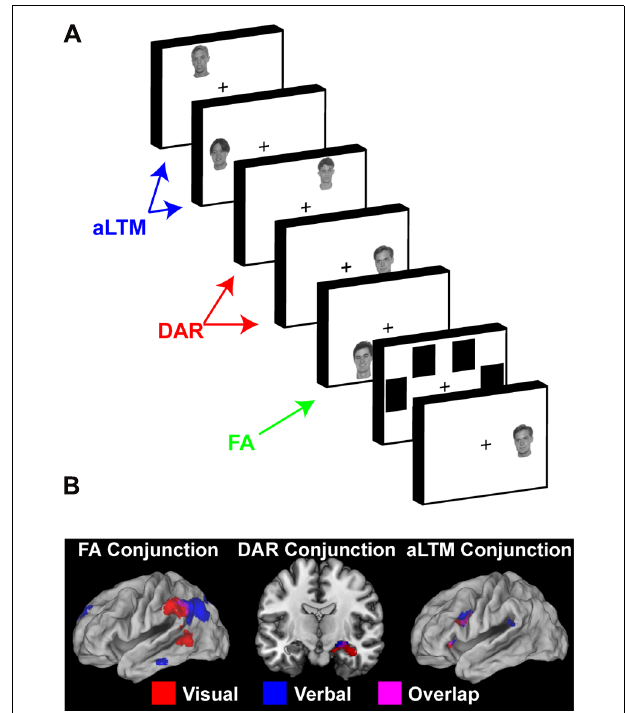
FIGURE 3 | Neural evidence for a three-state model of memory. (A) The task used by Nee and Jonides (2013) to examine neural correlates of the focus of attention (FA), direct-access region (DAR), and aLTM in visual STM. The task involved sequential presentation of five faces followed by a mask and a recognition probe. In this task, the number of presented items exceeded the capacity of the direct-access region. So, it was assumed that the least recent items (i.e., first presented items) would no longer be contextually bound and be represented in aLTM rather than the direct-access region. Reprinted from Nee and Jonides (2013) with permission from Elsevier. (B) Conjunction of results across a six-word version of the paradigm depicted in Figure 2 (Nee and Jonides, 2011) and the five-face paradigm depicted in (A) (Nee and Jonides, 2013). Across both studies, probes matching the focus of attention activated ventral posterior parietal cortex (VPC), probes matching the direct-access region activated the medial temporal lobe (MTL), and probes matching the aLTM activated the ventrolateral prefrontal cortex (VLPFC). In all cases, activations related to a given state were dissociable from those involved in the access of other representational states.This triple dissociation supports the three-state model of memory. Reprinted from Nee and Jonides (2013) with permission from